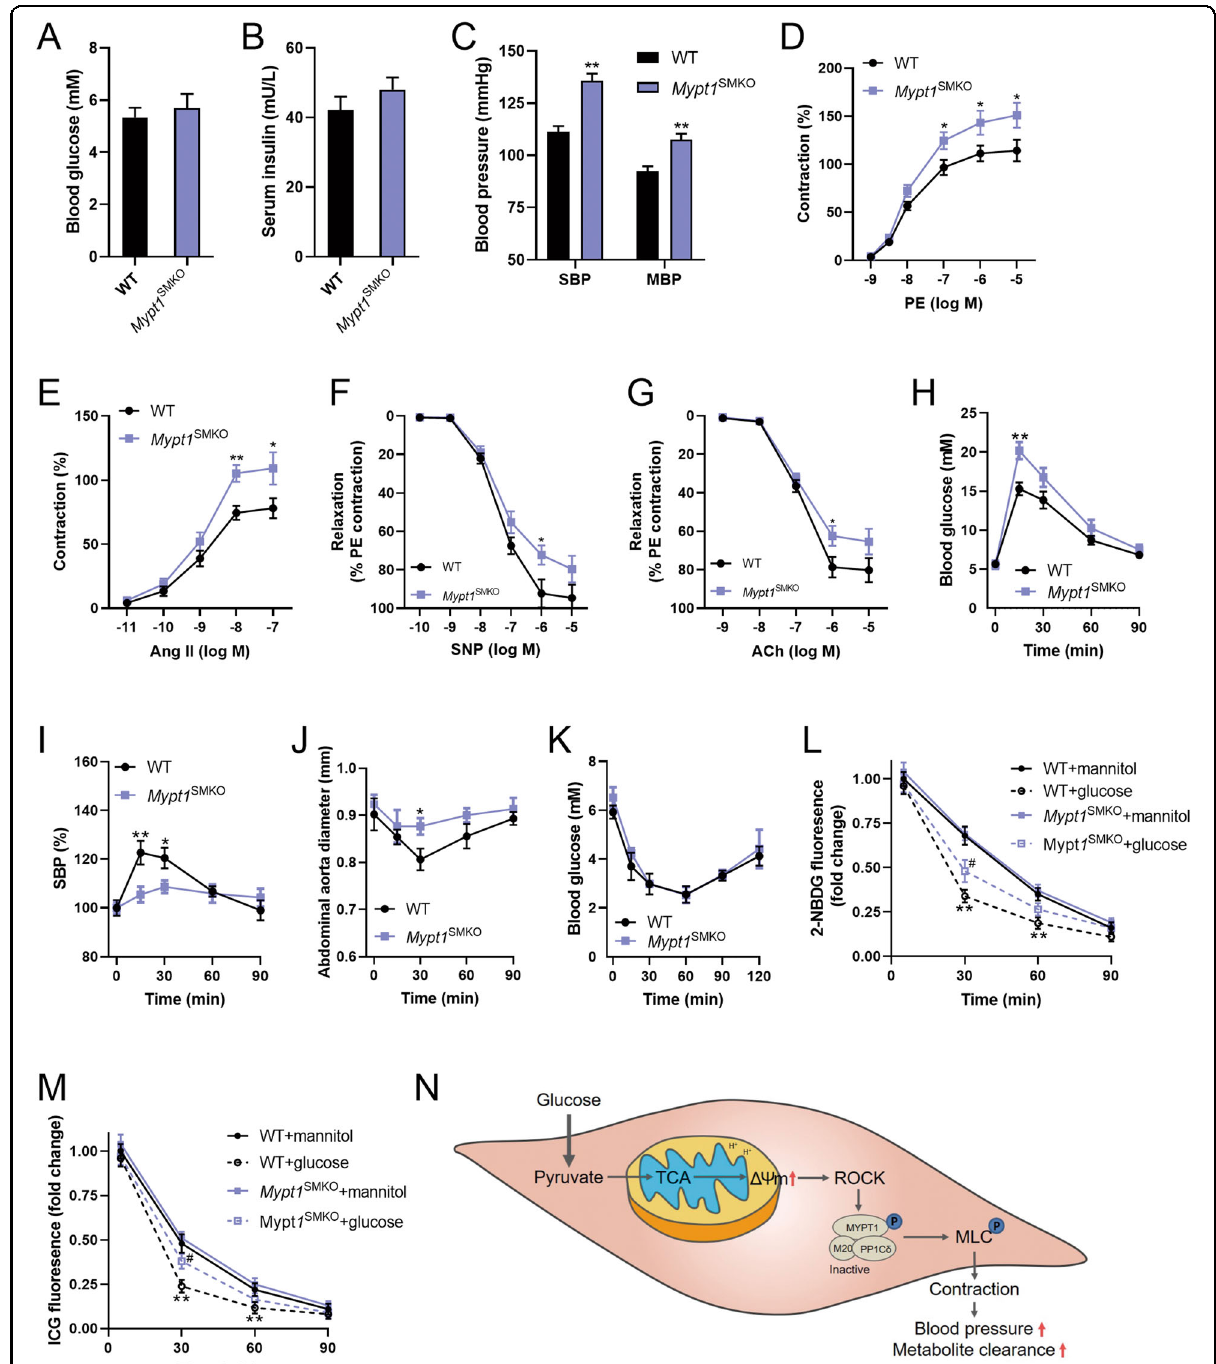
Fig. 6 Mypt1 SMKO mice displayed glucose intolerance and impaired metabolite clearance in response to glucose challenge. A , B Fasting blood glucose ( A ) and serum insulin ( B ) in WT and Mypt1 SMKO mice. n = 8. C Systolic blood pressure (SBP) and mean blood pressure (MBP) in WT and Mypt1 SMKO mice. n = 8. D , E Vascular constriction in response to PE ( D ) and Angiotensin II ( E ) in isolated aortas from WT and Mypt1 SMKO mice. n = 6. F , G Vascular relaxation in response to SNP ( F ) and ACh ( G ) in isolated aortas from WT and Mypt1 SMKO mice. n = 6. H – J Blood glucose ( H ), SBP ( I ), and abdominal aorta diameter ( J ) in response to glucose challenge in WT and Mypt1 SMKO mice. n = 8. K Blood glucose in response to insulin challenge in WT and Mypt1 SMKO mice. n = 8. L , M Circulating 2-NBDG ( L ) and ICG ( M ) fl uorescence in response to glucose challenge in WT and Mypt1 SMKO mice. n = 8. * , vs. WT + saline; #, vs. WT + glucose. N The graphic summary of our fi ndings. Error bars represent SEM. * P < 0.05. # P < 0.05. ** P <